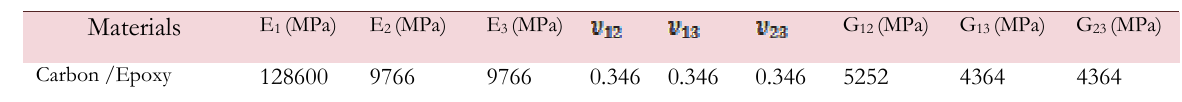
Table 3: Mechanical properties of the composite patch Carbon/epoxy.